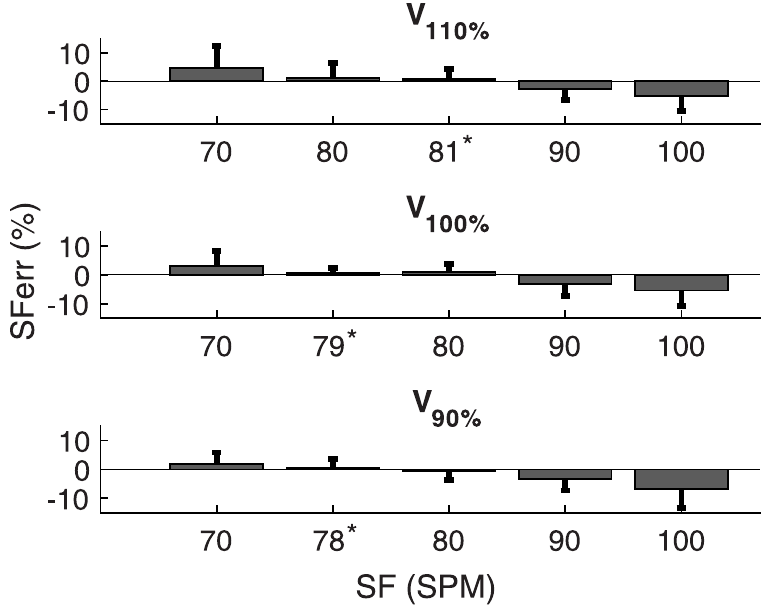
Fig 3. Average error scores calculated from the observed stride frequency (SF) relative to the imposed SF. The asterisk denotesthe averageself-selected SF.